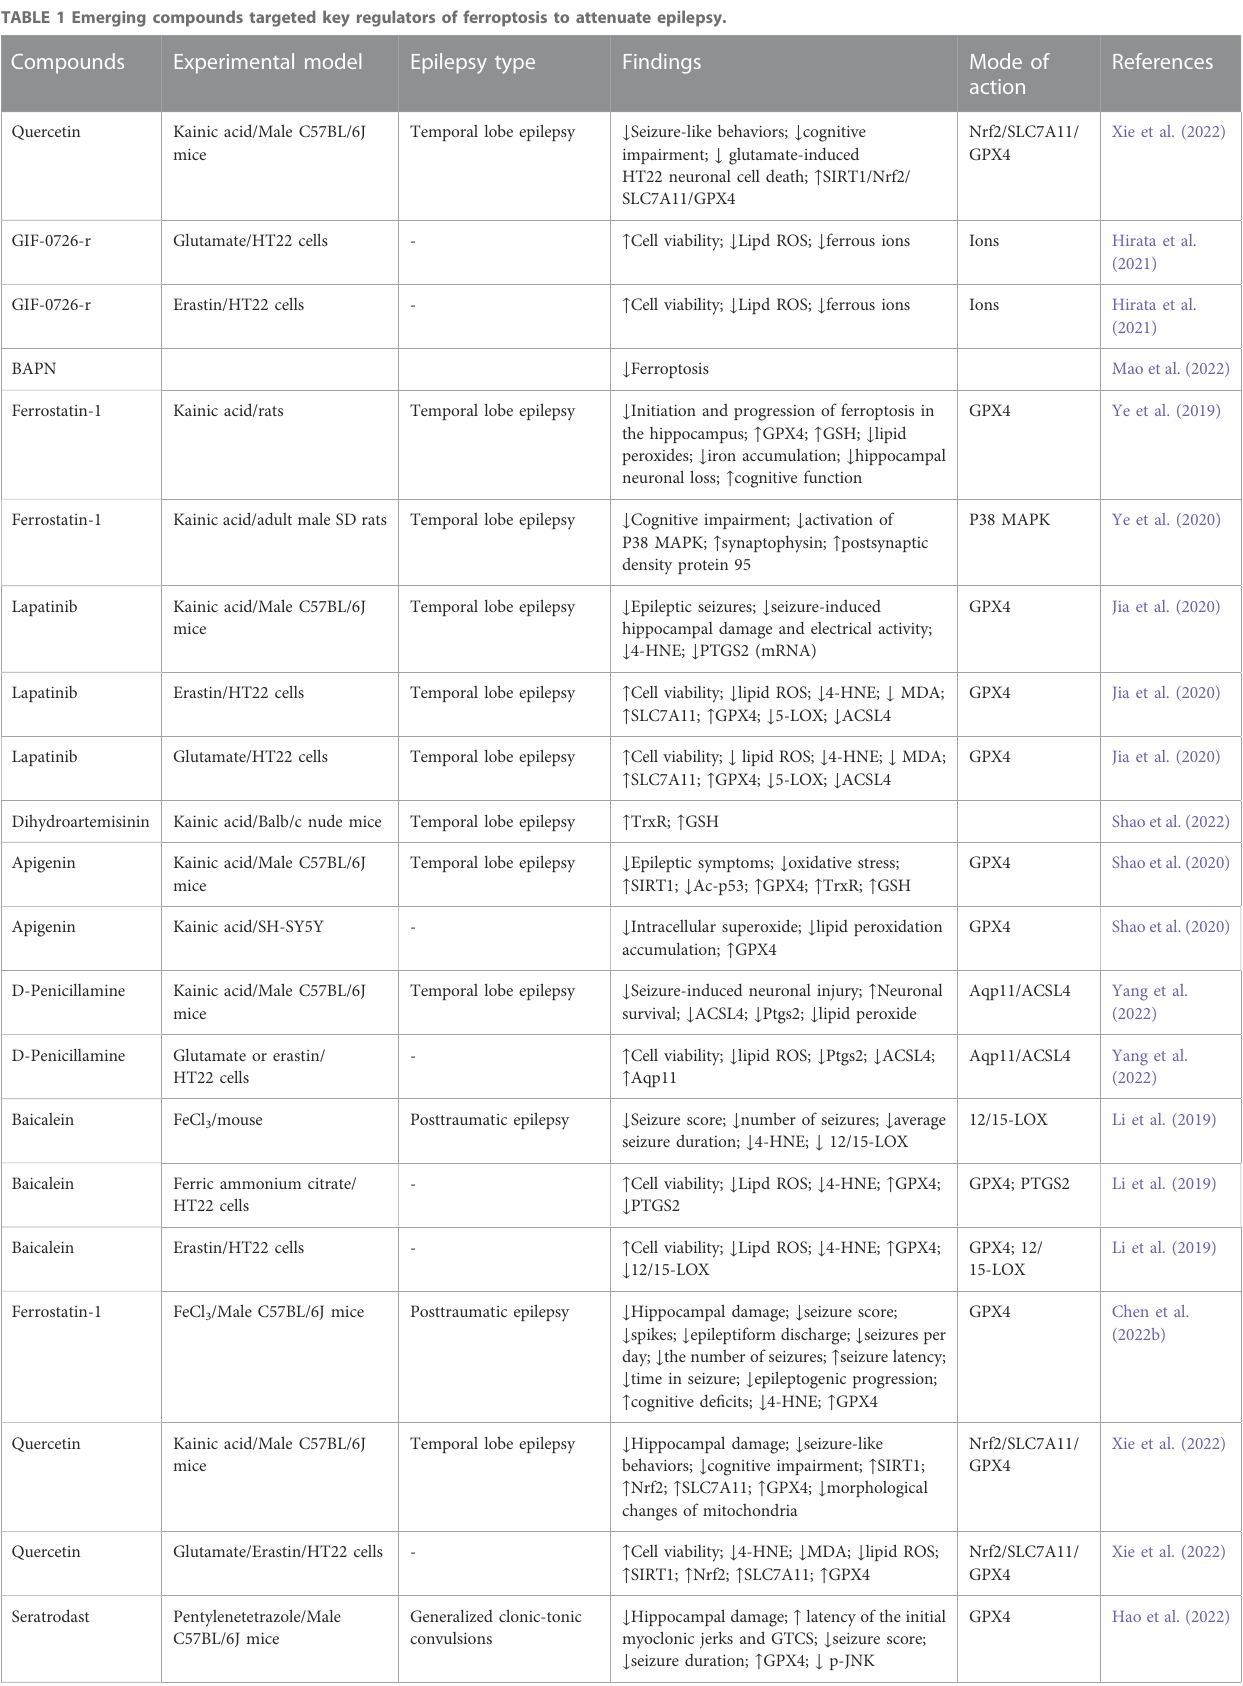
TABLE 1 Emerging compounds targeted key regulators of ferroptosis to attenuate